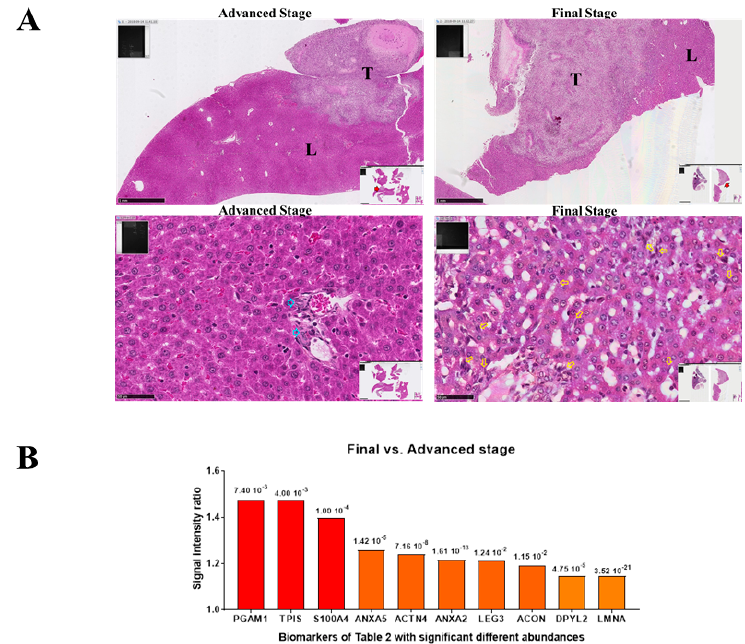
Figure 4. Comparison between liver metastases and primary tumor, M5-T1 tumor model. (A) Histological features of the two stages identified in the colonization of the liver by M5-T1 cells. Top rank, general views (×25, the scale bar represents 1 mm) showing the extent of tumor (T) development within the liver tissue (L). Bottom rank, detailed views (×400, the scale bar represents 50 µm). The final stage was characterized by the presence of numerous isolated metastatic M5-T1 cells infiltrating the liver parenchyma (yellow arrows), in contrast to the advanced stage for which the tumor cells were only localized within the portal triad (blue arrows). (B) Proteomic analysis: Abundance ratios (final versus advanced stage) for the 11 biomarkers exhibiting significant differences ( p < 0.05), and also found in the list of 39 biomarkers detailed in Table 2, p values are indicated for each biomarker at the top of the bars.